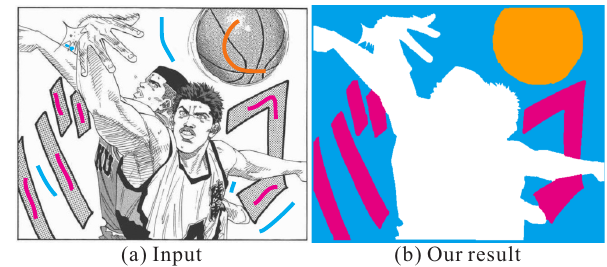
Fig. 13 ‘Basketball’ (1251 × 1013, loading time: 7.97s, processing time: 6.27s).